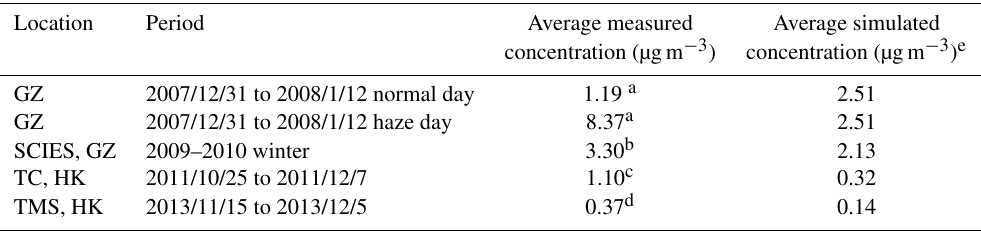
Table 4. Comparison of measured and simulated chloride (base case).